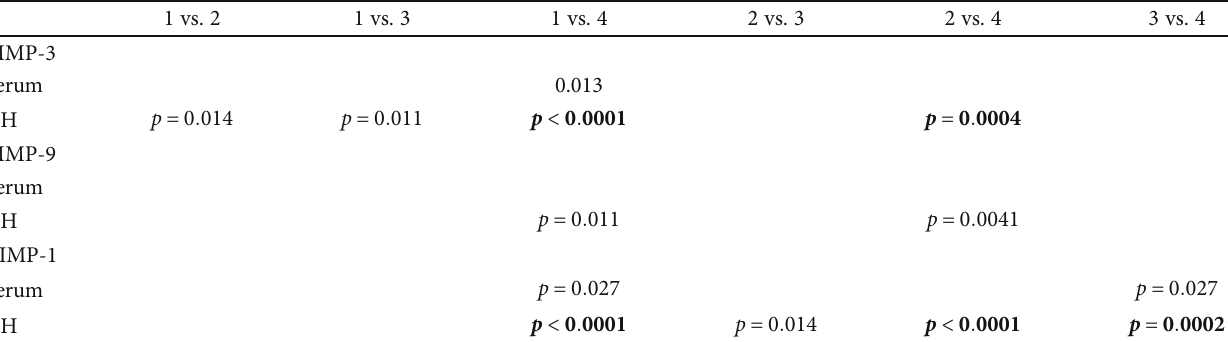
Figure 2: Scatter plots (log scale pg/ml) showing the concentrations of MMP-3 (a), MMP-9 (b), and TIMP-1 (c) in serum and AH throughout the di ff erent stages of DR. The values below the LLOQ were replaced with half the value of the LLOQ. Black lines represent the median value for each group. The dotted line shows the LLOQ of the assay for each protein. ∗∗ p < 0 : 01 . Table 5: Comparison of concentrations of MMP-3, MMP-9, and TIMP-1 in serum and AH of healthy individuals (controls) and diabetic patients with di ff erent stages of